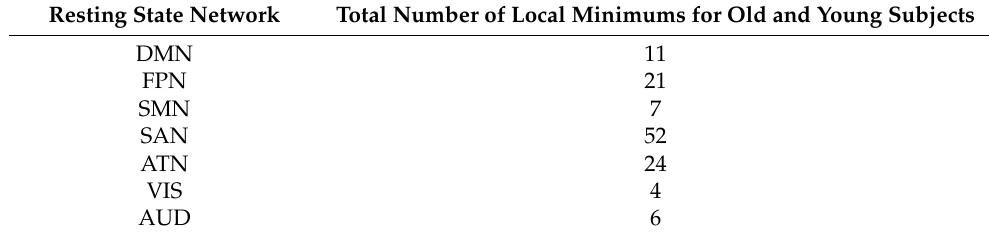
Table 1. Total number of local minimums for each RSN. Resting State